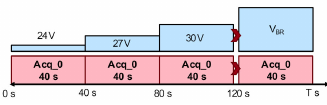
Figure 7. Electroluminescence imaging procedure coupled with step stress.